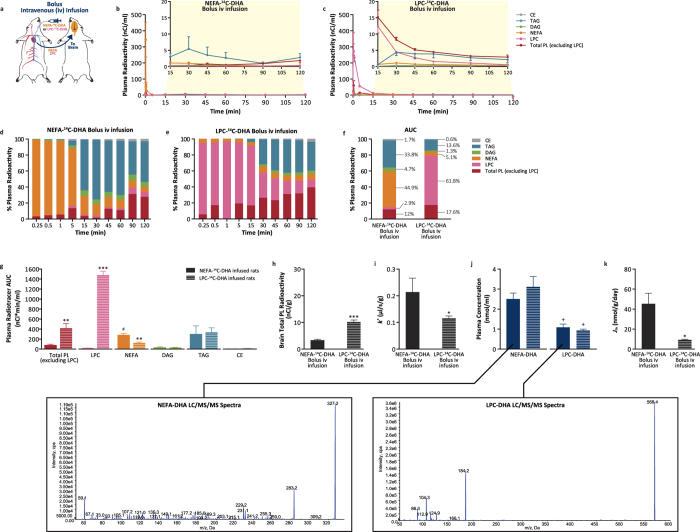
Plasma LPC-DHA contribution to brain total DHA uptake via bolus iv infusion kinetic modeling.(a) Schematic diagram of iv infusion kinetic modeling. (b,c) Plasma lipid radioactivity from NEFA-14C-DHA or LPC-14C-DHA bolus iv infusion (13 μCi) followed by 2-hour plasma sampling (n = 4 each). (d,e) Percent composition of various radiolabeled lipid pools in the plasma at each time point following an acute iv bolus infusion of NEFA-14C-DHA or LPC-14C-DHA. (f) Percent composition of various radiolabeled lipid pools in the plasma over 2-hour period following an acute iv bolus infusion of NEFA-14C-DHA or LPC-14C-DHA. (g) Plasma radiotracer exposure from various lipid pools after bolus iv infusion of NEFA-14C-DHA or LPC-14C-DHA. (h) Brain radioactivity of total phospholipids from rats iv infused with bolus NEFA-14C-DHA or LPC-14C-DHA. (i) The uptake incorporation coefficient (k*) into brain total phospholipids from rats iv infused with bolus NEFA-14C-DHA or LPC-14C-DHA. (j) The baseline plasma concentration of total NEFA-DHA and LPC-DHA prior to NEFA-14C-DHA or LPC-14C-DHA bolus iv infusion. LC/MS/MS spectra of NEFA-DHA and LPC-DHA. (k) The net incorporation rate of DHA (Jin) into brain total phospholipids from rats iv infused with bolus NEFA-14C-DHA or LPC-14C-DHA. Percent plasma radioactivity data are expressed as mean. Remaining data are expressed as mean ± SEM. *P < 0.05, **P < 0.01 and ***P < 0.001 indicate significant difference from NEFA-14C-DHA infused rats. +P < 0.01 indicates significant difference between plasma LPC-DHA and NEFA-DHA concentration. #P < 0.001 indicates significant difference between radiolabeled LPC pool from LPC-14C-DHA infused rats and radiolabeled NEFA-DHA pool from NEFA-14C-DHA infused rats. Students’ t-test was used to determine significant difference. See Fig. 2 for abbreviations.